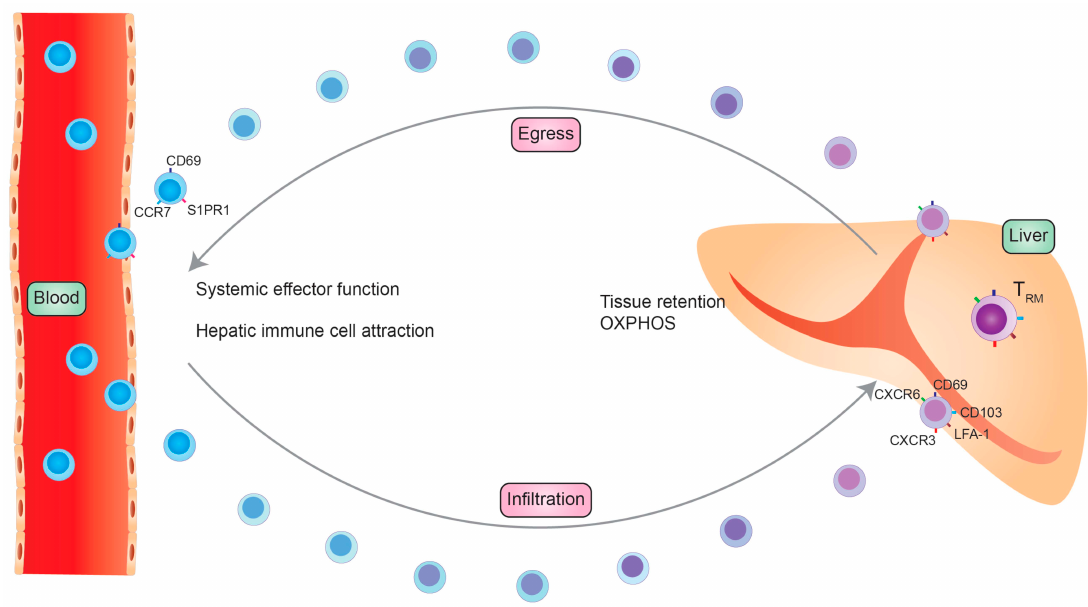
Figure 2. Upon stimulation, T RM cells can recirculate into the blood by inducing the expression of higher levels of CD69, CCR7 and S1PR1. In the blood they can have systemic effector functions and convey hepatic immune cell attraction. For the infiltration into the liver, memory T cells express high levels of the hepatic homing markers LFA-1, CD103, CXCR6, CXCR3 and CD69. In the liver they downregulate the expression of these homing receptors and differentiate into liver-resident T RM cells. These findings suggest that although T RM cells might be able to reside in a specific tissue for